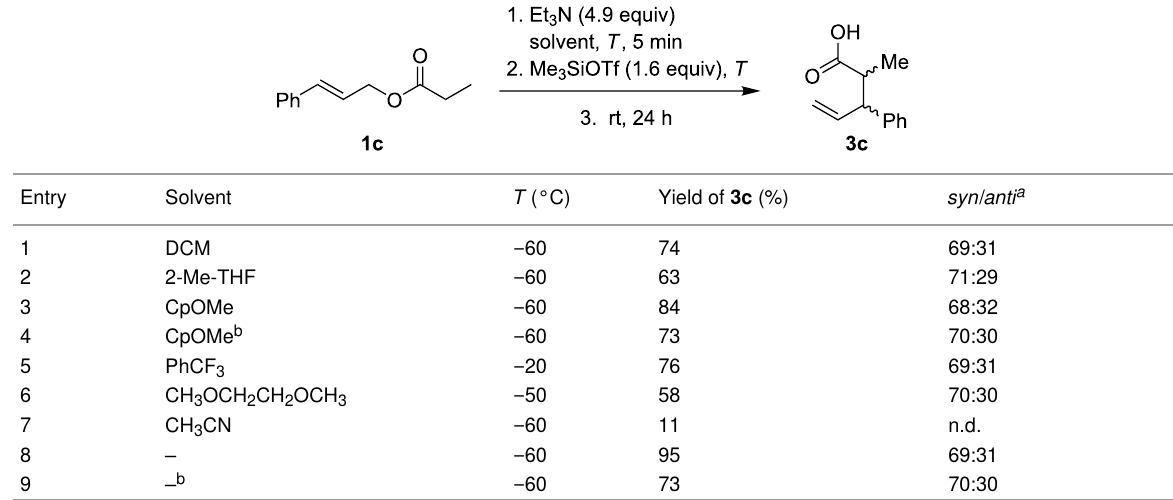
Table 5: Green solvents screening for the Ireland–Claisen rearrangement of 1c